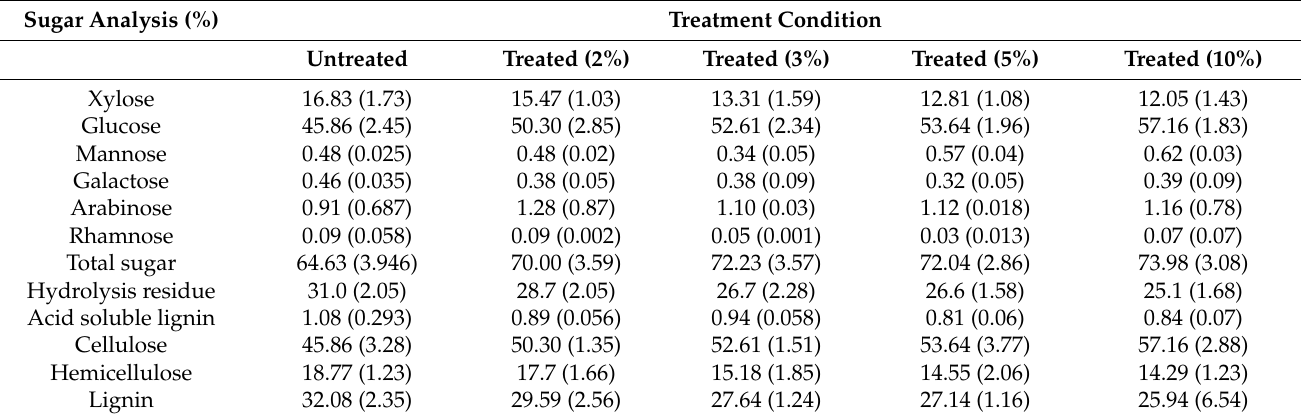
Table 2. Results of chemical characterization of EHB subjected to different ranges of alkaline